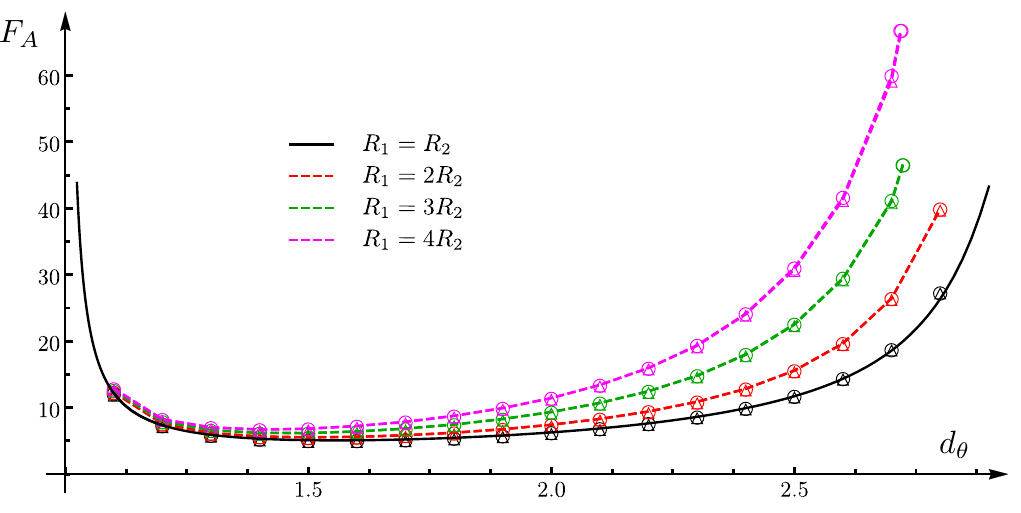
Figure 6 . Finite term F A in terms of d (cid:18) in the range 1 < d (cid:18) < 3 for minimal surfaces in hvLif 4 anchored to ellipses A having (cid:12)xed perimeter P A = 1. Di(cid:11)erent colours correspond to ellipses with di(cid:11)erent eccentricity. The data points have been obtained with Surface Evolver in the two ways described in (5.20) (the markers have been assigned as in the previous (cid:12)gures). The solid black curve, that corresponds to the disk, is the curve reported in (cid:12)gure 2 multiplied by ( P A = (2 (cid:25)R )) 2 (cid:0) d (cid:18) .